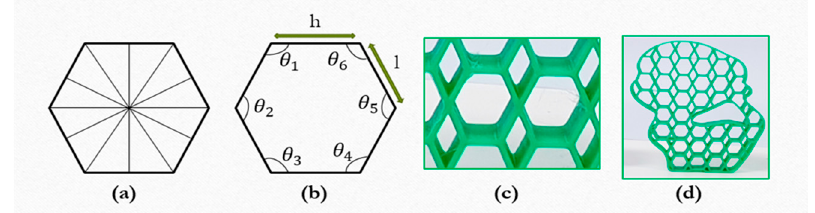
Figure 3. The regular hexagonal element with ( a ) symmetrical lines and. ( b ) geometric parameters including interior angles ( c ), and ( d ) outputs.